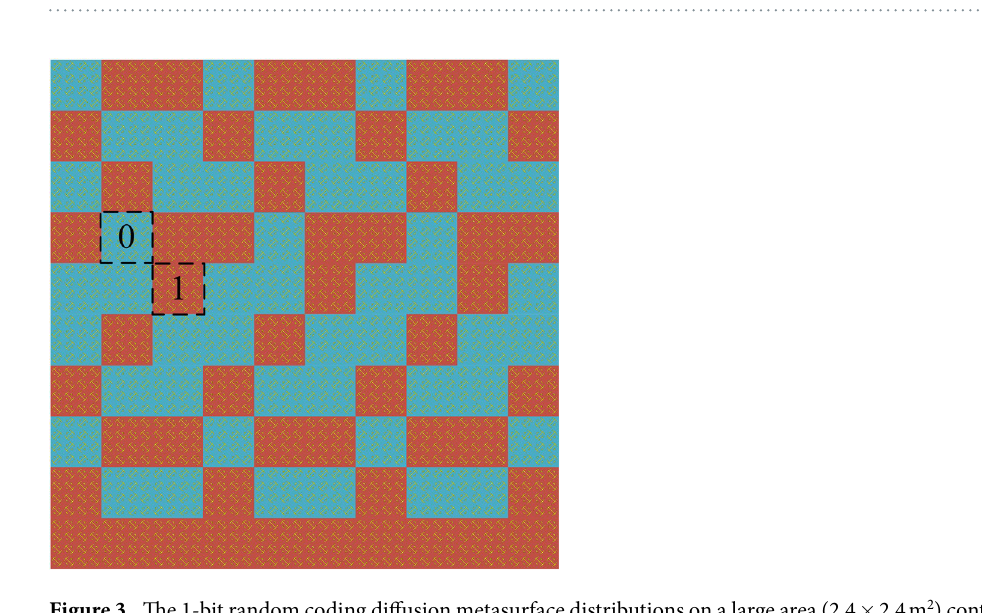
Figure 2. The reflected amplitudes and phases of the “0” and “1” elements under normal incident waves in simulation. Because of the anisotropy of the metasurface, there is a phase difference ( ∆ ϕ ) between the “0” and “1” elements.